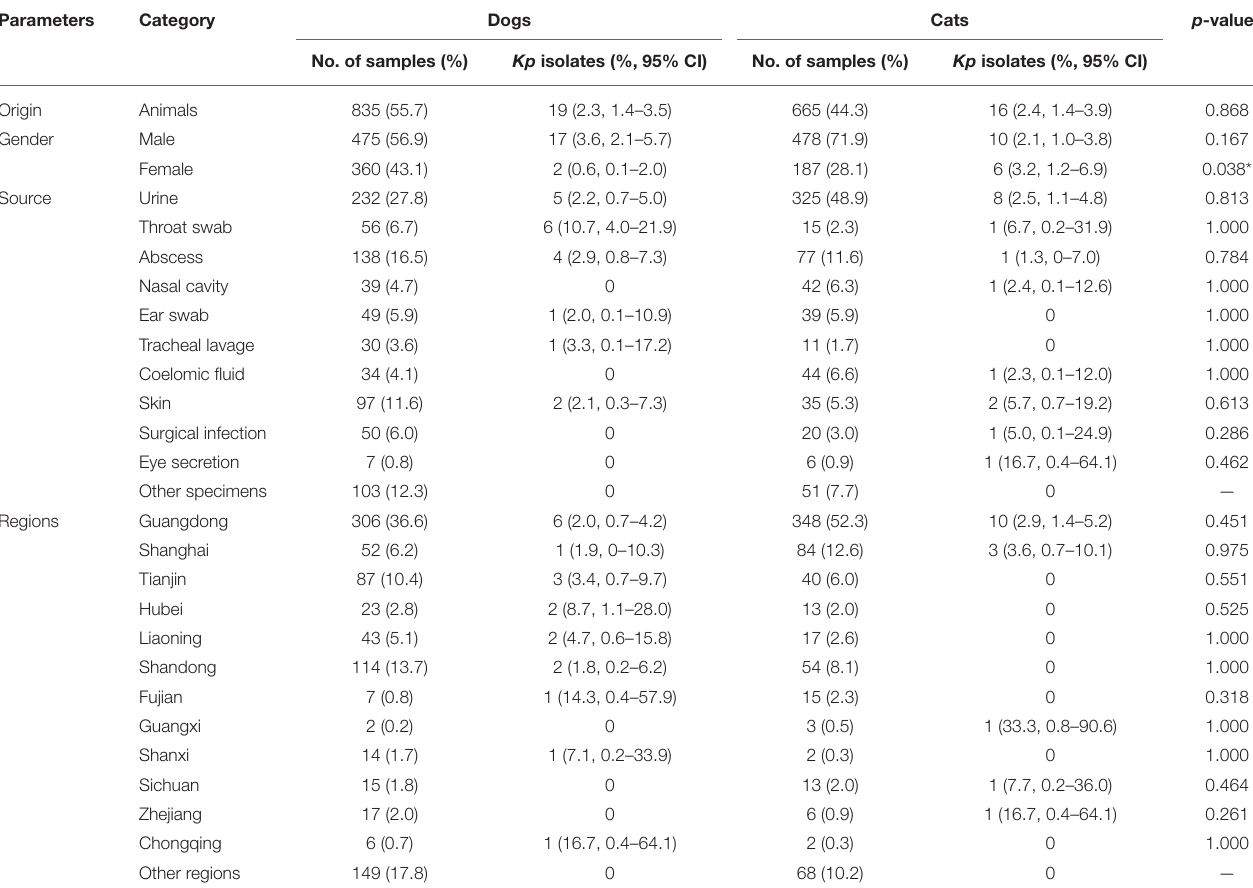
TABLE 1 | The prevalence and distribution of K. pneumoniae complex from dogs and cats.